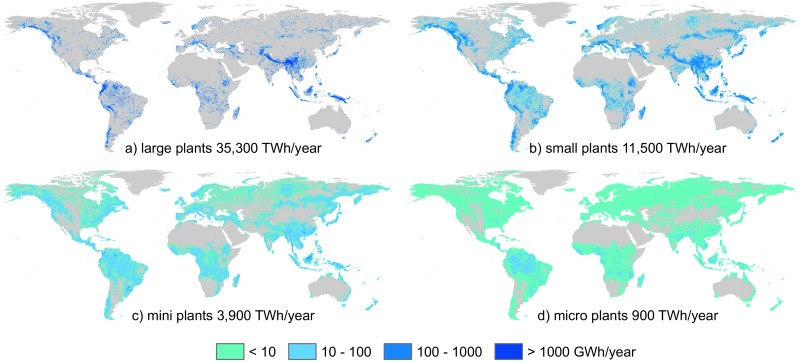
Global number of gross potential hydropower locations of a certain size.Total number of locations found is 1.2 × 107. For Micro: N = 8.0 × 106, Mini: N = 2.7 × 106, Small: N = 8.8 × 105, Large: N = 1.6 × 105. The empirical fits allow the computation of the number of locations in a certain range while choosing an arbitrary bin size. The number of potential pico hydropower locations would be larger if computations were performed on a finer-resolution grid. For the separation between the classes, a capacity factor of 0.5 was used.